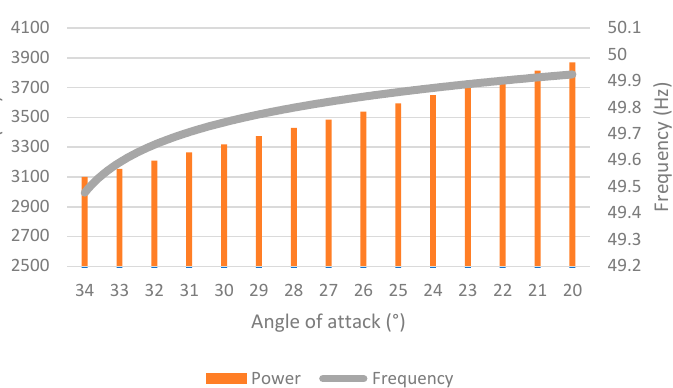
Figure 10. Graphical dependence of power regulation—increasing [source: author’s archive] .